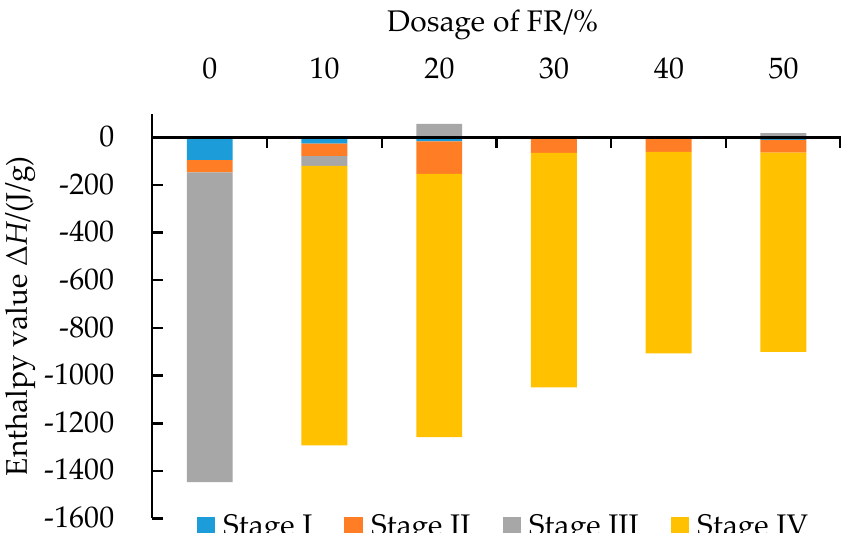
Figure 5. Enthalpy of FRA during the combustion process. Stage I (245~390 ◦ C): The TG curve gradually decreased, indicating that the light components of the asphalt binder volatilized under heat, and reacted with oxygen to decompose and condense, forming substances such as colloids. The differential scanning calorimetry (DSC) curve had an exothermic peak. In this stage, the C-C bonds and unstable weak bonds of the side chains in the asphalt binder molecules broke and generated radicals, and their interaction with oxygen released